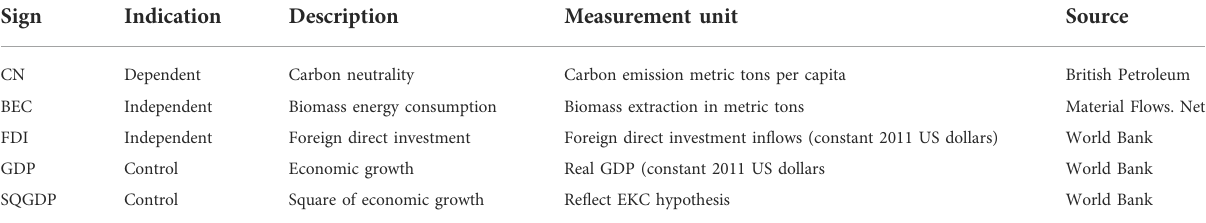
TABLE 1 Variables of the